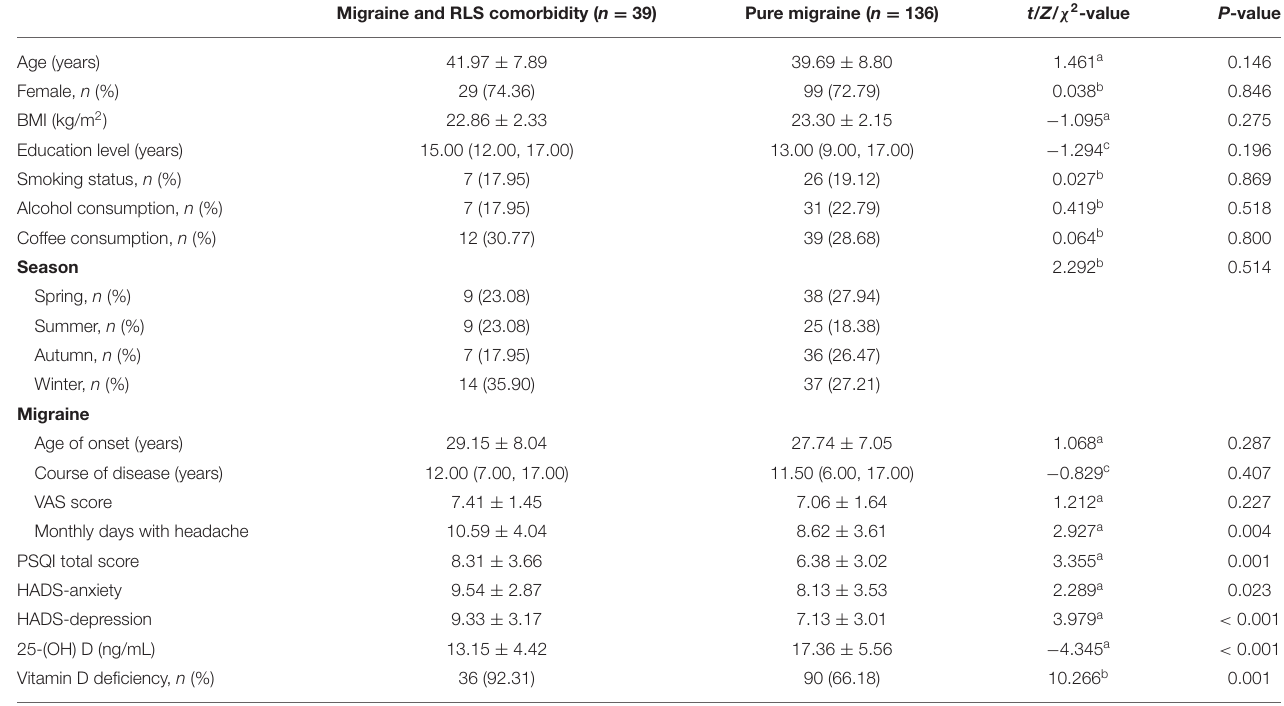
TABLE 3 | Clinical data and vitamin D levels between migraine and RLS comorbidity group and pure migraine group. Migraine and RLS comorbidity ( n = 39) Pure migraine ( n = 136) t / Z / χ 2 -value P -value